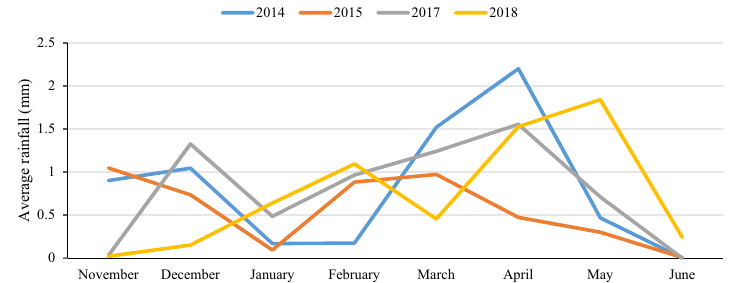
Figure 1. Average rainfall in different months each